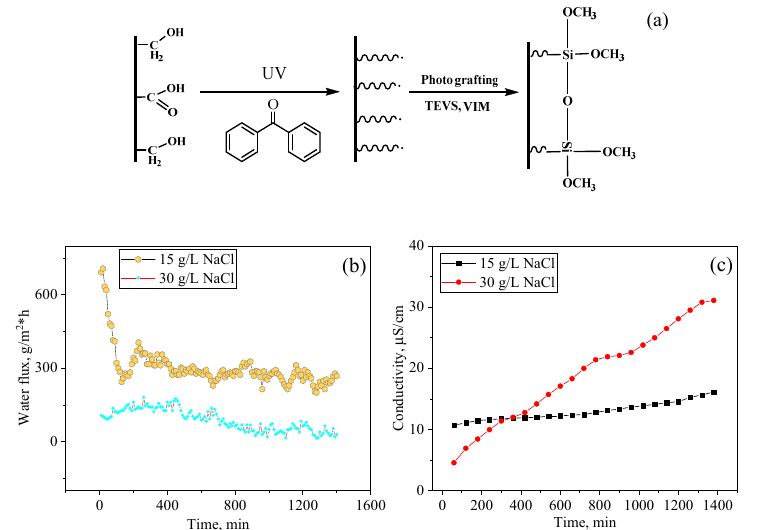
Figure 5. Scheme of surface modification of PET TeMs with TEVS ( a ); water flux ( b ) and electrical conductivity ( c ) for NaCl solutions with concentrations of 15 and 30 g/L. Adapted from [130].